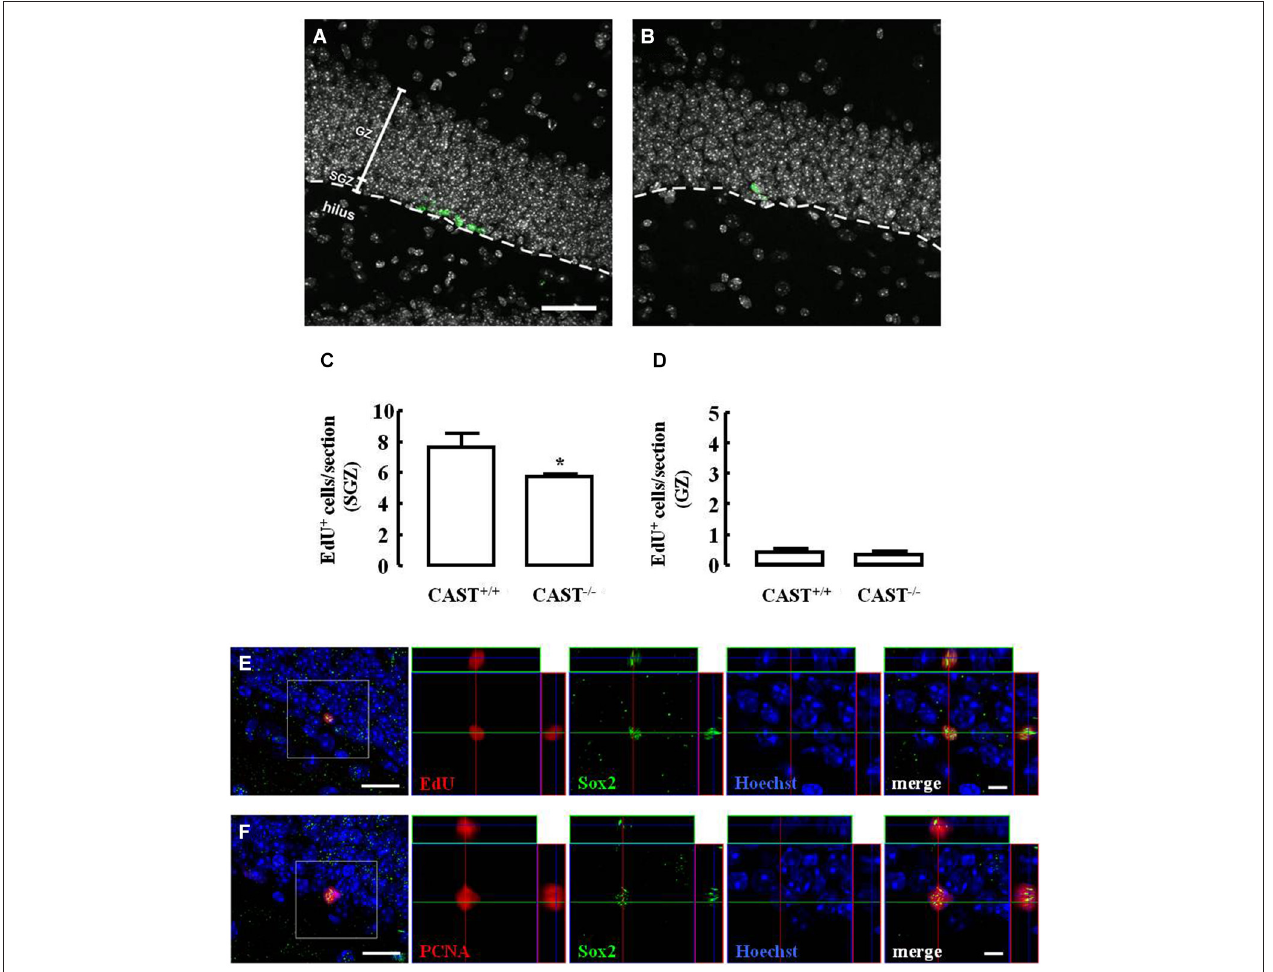
nuclear antigen (PCNA) (F) , in red, with the transcription factor Sox2, in green; nuclei are labeled with Hoechst 33342, in blue. Scale bars: 40 µ m for (A) and (B) ; 10 µ m for the left panels of (E) and (F) ; 5 µ m for the right panels of (E) and (F) . Means ± SEM of at least 3 independent experiments. Two-tailed t -test, ∗ p < 0.05 (significantly different from Cast + / +